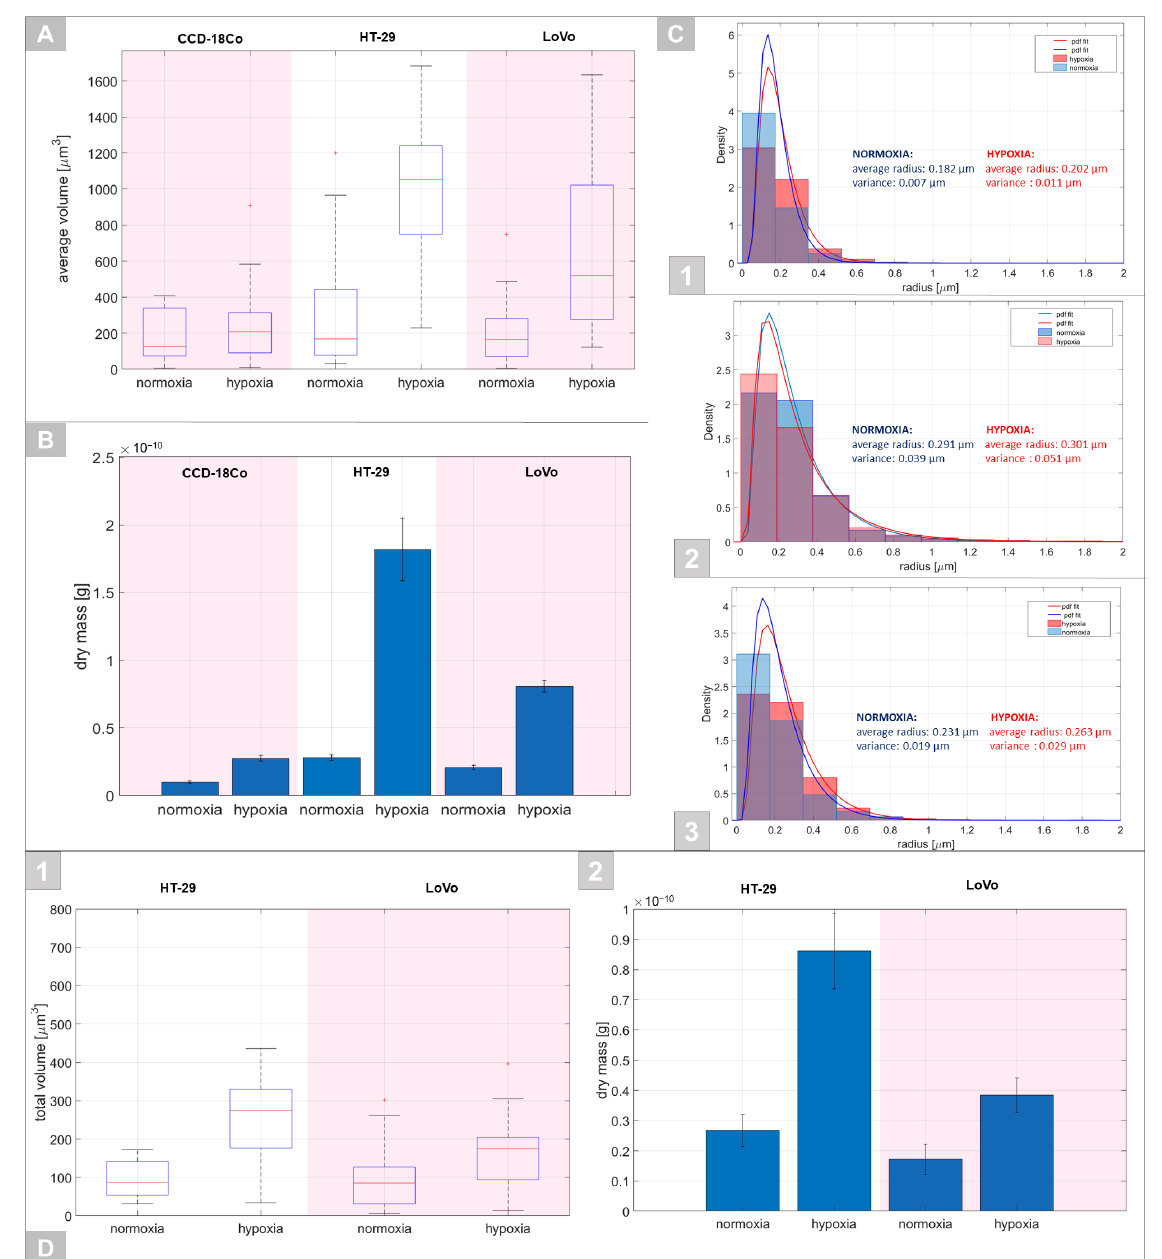
Figure 6. ( A ) The variation of the average volume of the vesicles/lipid droplet-like structures of examined cells in both normoxic and hypoxic conditions. ( B ) A comparison of the dry mass of detected structures in analyzed samples under normoxic and hypoxic conditions. ( C ) The determined distribution of the radius of these structures in analyzed cultures: CCD-18Co (1), HT-29 (2), LoVo (3) cells under normoxic and hypoxic environments with fitted probability density functions (pdf). ( D ) The comparison of the variation of the total volume of the high RI fraction (RI > 1.375) structures in cancer cells (1) and their dry mass